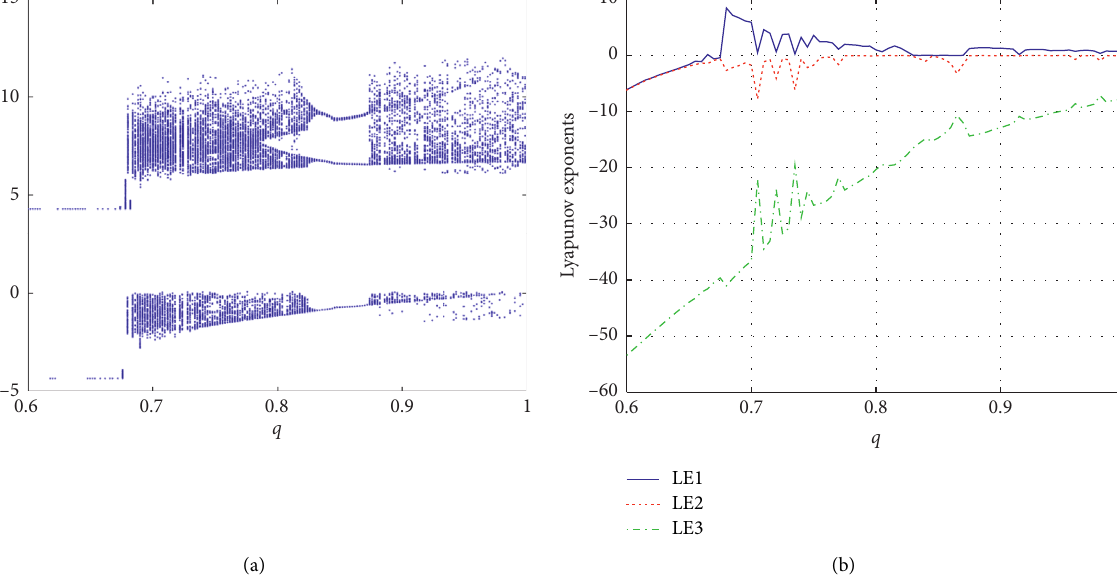
Figure 6: Bifurcation diagram and Lyapunov exponents spectrum of system (11) with a � 5, b � 2, and c � 34. (a) Bifurcation diagram. (b) Lyapunov exponents